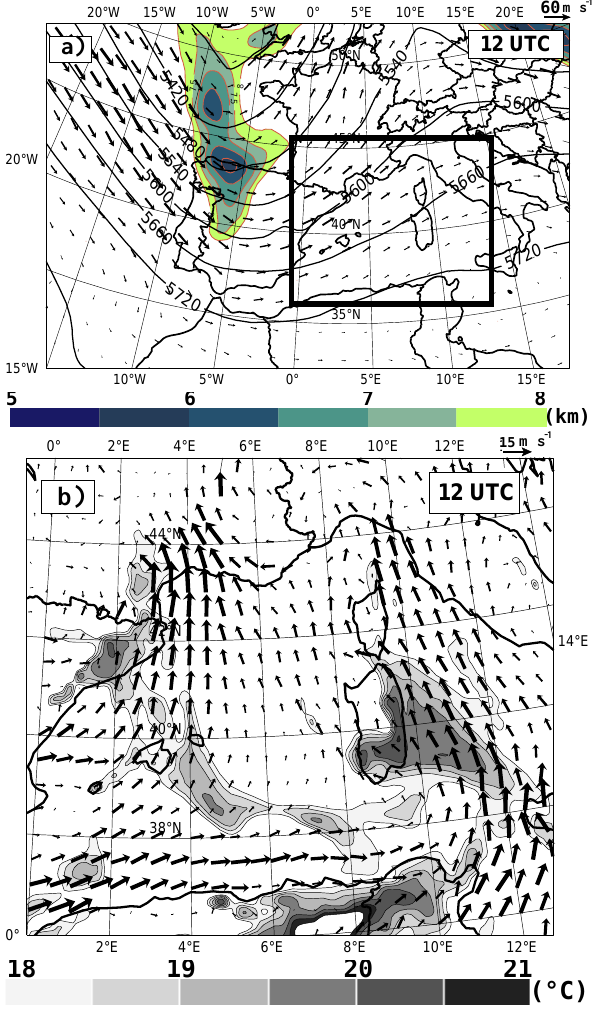
Fig. 3. Gard case (a) : 300hPa winds (arrows), 1.5PVU surface Fig. 3. Gardcase a) : 300 hPawinds(arrows), 1.5 PVUsurface height (colour) and 500 hPageopotential height (solidline) and b) : adiabatic wet-bulb potentail temperature (shading) and horizontal winds at 925 hPa, from ARPEGE analysis on 07 September 2010 at 12 UTC. The height (colour) and 500hPa geopotential height (solid line) and (b) : black rectangle represents the domain seen in b) . adiabatic wet-bulb potentail temperature (shading) and horizontal winds at 925hPa, from ARPEGE analysis on 7 September 2010 at 12:00UTC. The black rectangle represents the domain seen in (b) .